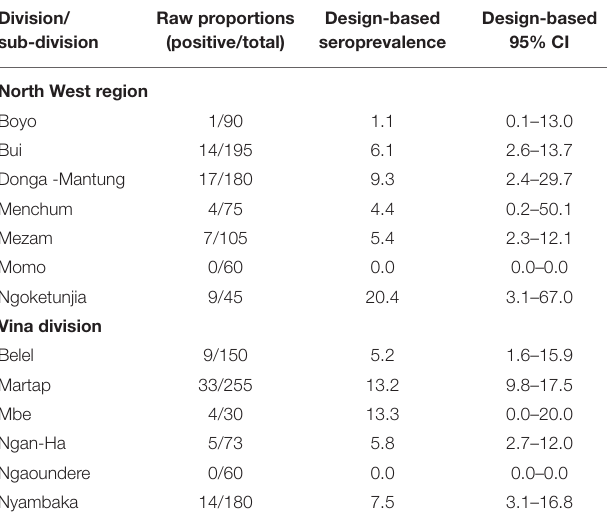
TABLE 1 | Design-based animal-level seroprevalence (not adjusted for test performance) of RVF antibodies in cattle in Cameroon in 2013 stratified by division (NWR) and sub-division